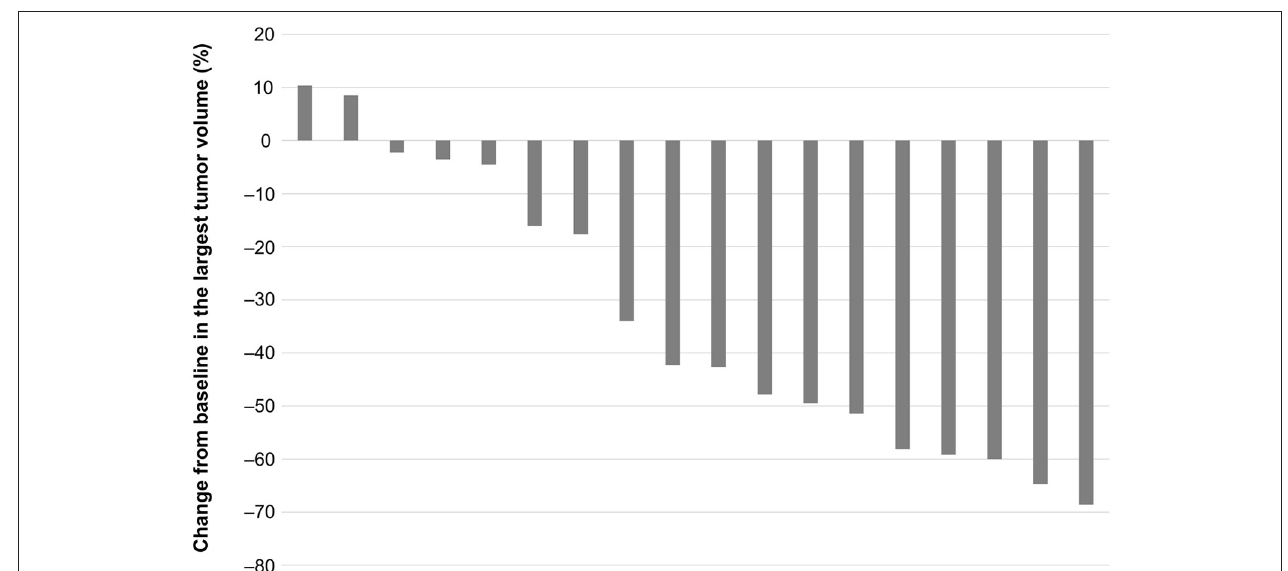
FIGURE 4 | Change in volume of largest primary or metastatic tumor from the start to the end of lenvatinib treatment.